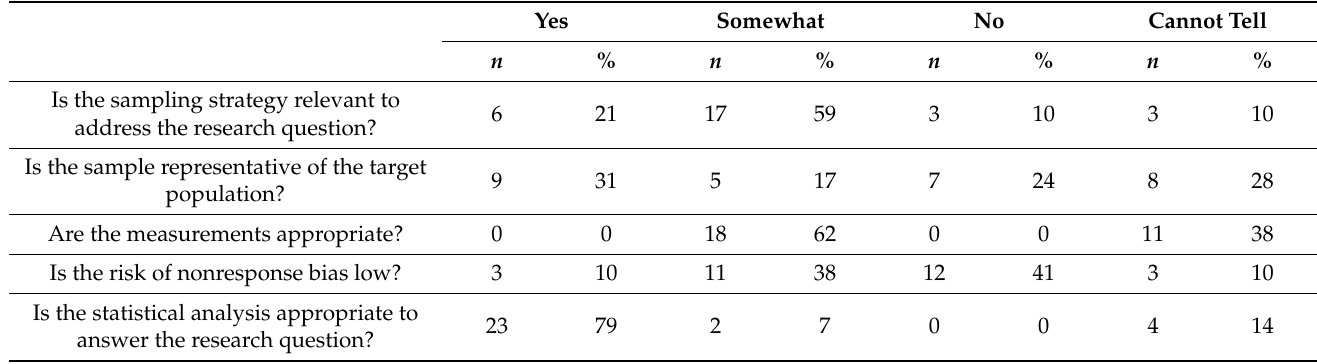
Table 8. Quality assessment results for studies included in the review ( n =